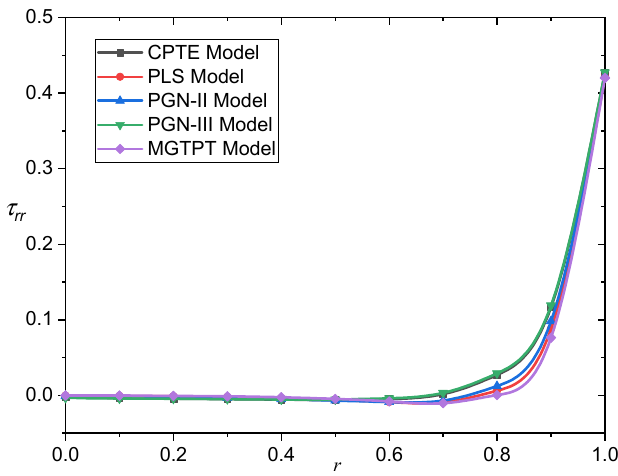
Figure 6 . The Maxwell’s stress (cid:2028) (cid:3045)(cid:3045) for different models of